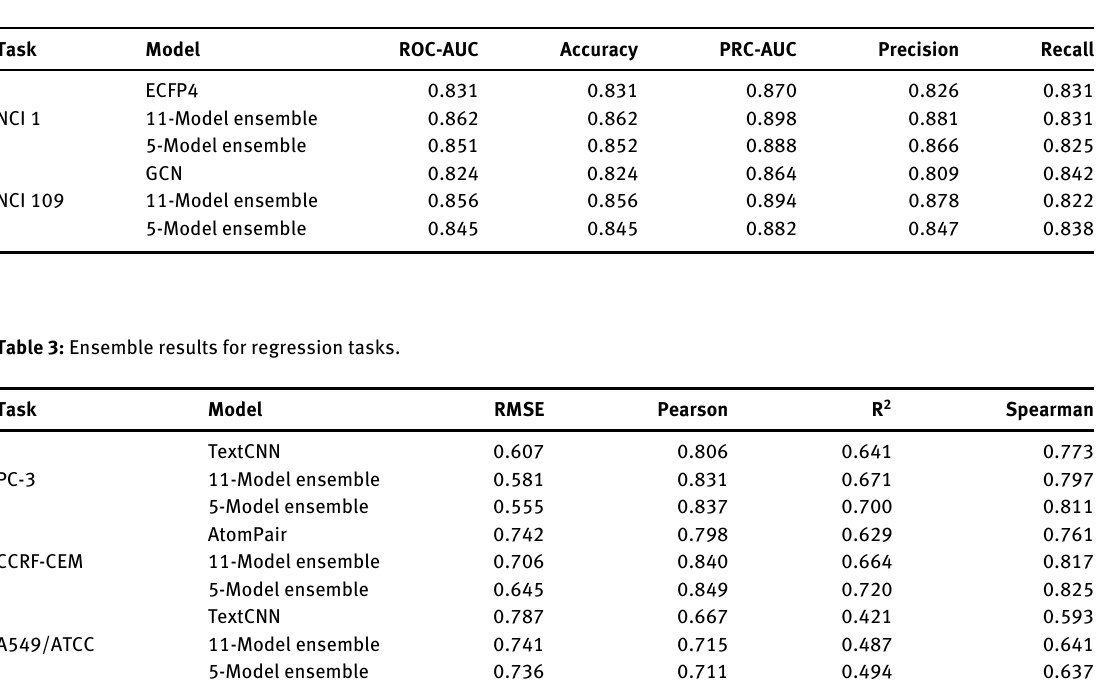
Table 2: Ensemble results for classification tasks.